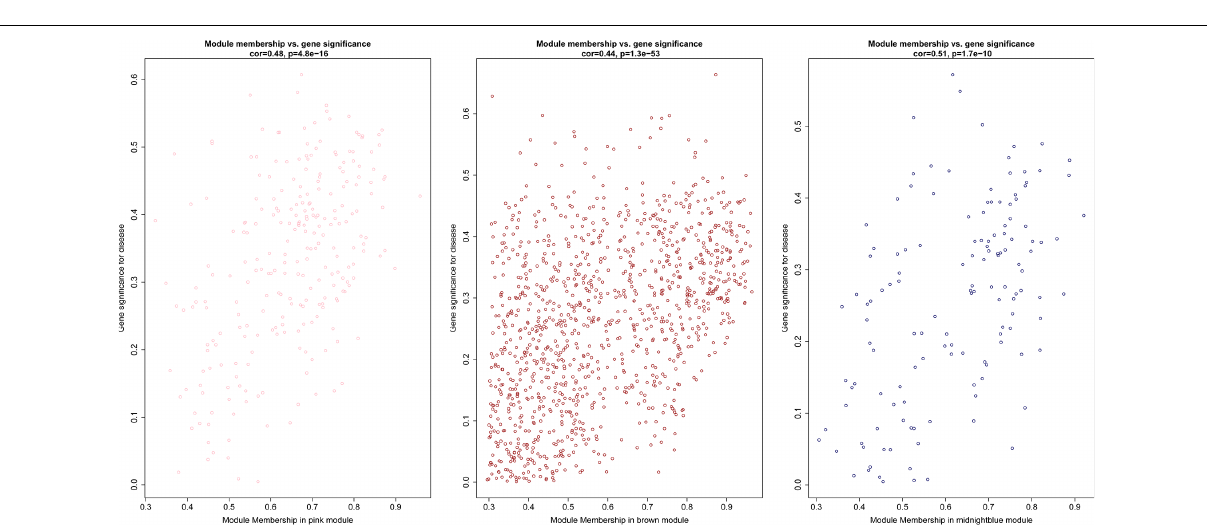
FIGURE 2 | Scatter diagram for module membership vs. gene significance of stage (BD or non-BD) in three